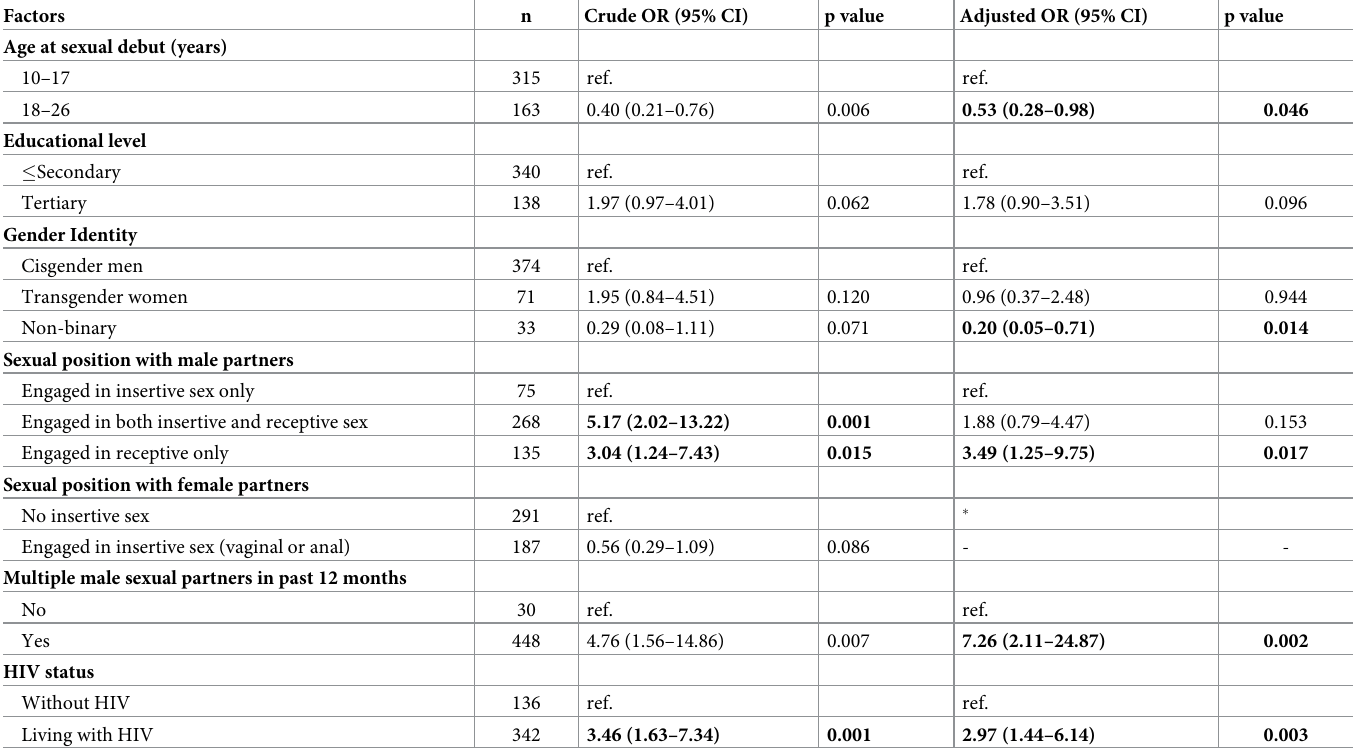
Table 3. Multivariable analysis showing factors associated with anogenital warts among MSM in